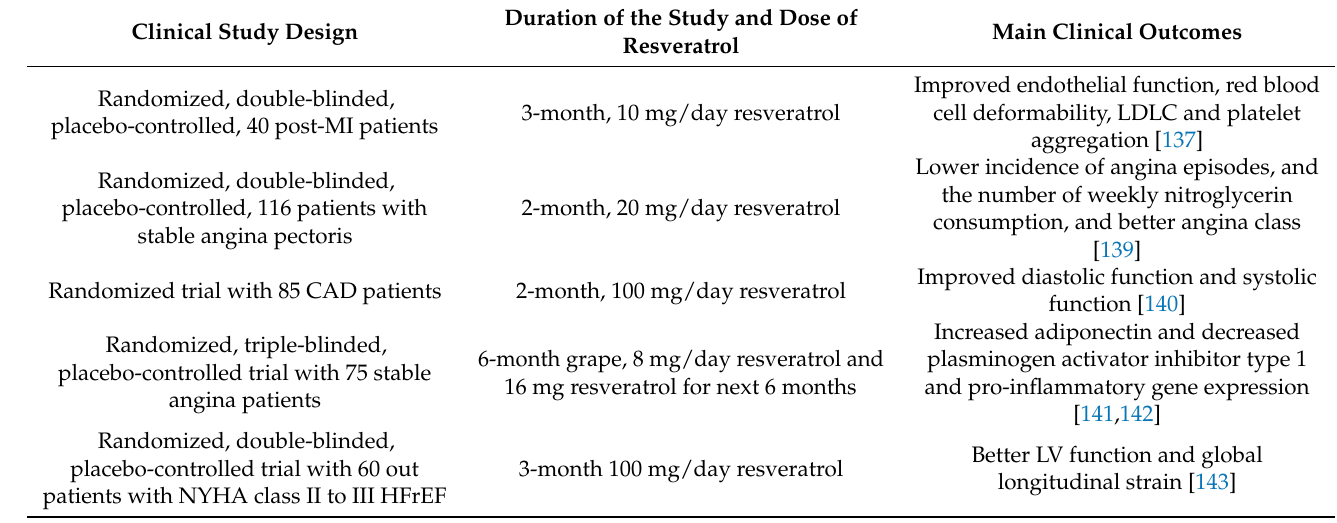
Table 3. Effects of resveratrol in improving various clinical parameters in randomized clinical trials in stable CAD patients. Clinical Study